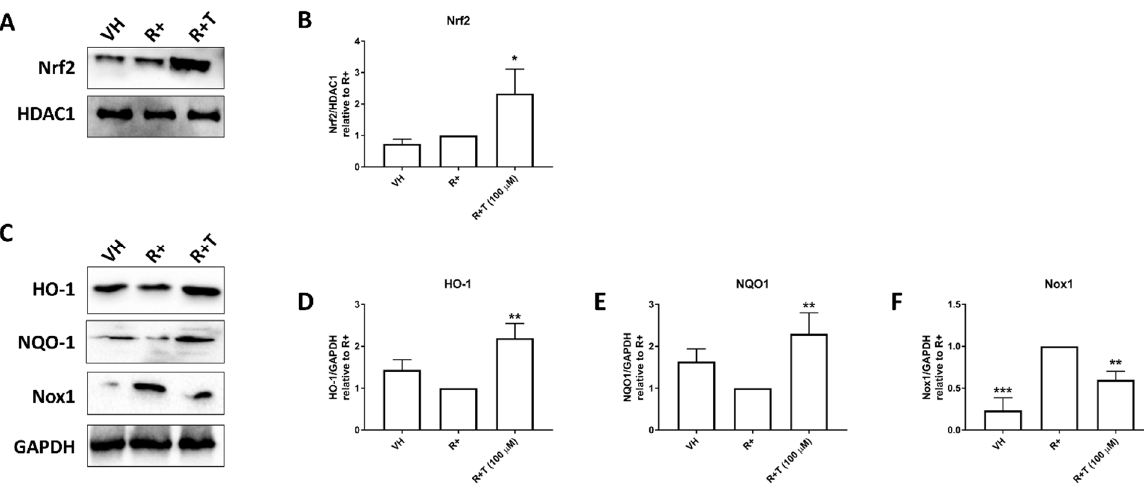
Figure 3. Effect of TUG-891 on expression of proteins involved in ROS production. RAW264.7 macrophages were seeded into 6-well plates and exposed to TUG-891 (100 µ M) and RANKL (15 ng mL − 1 ). After 24 h a Western blot was performed to determine protein expression. ( A ) Representative Nrf2 and HDAC1 blot. ( B ) Quantification of Nrf2 blots from at least two repeated experiments. ( C ) Representative HO-1, NQO1, Nox 1 and GAPDH blot. ( D – F ) Quantification of HO-1, NQO1 and Nox1 blots respectively from at least two repeated experiments. VH: vehicle control. R+: RANKL only. R+T: RANKL + TUG-891. * p < 0.05, ** p < 0.01, *** p < 0.001 vs. R+.